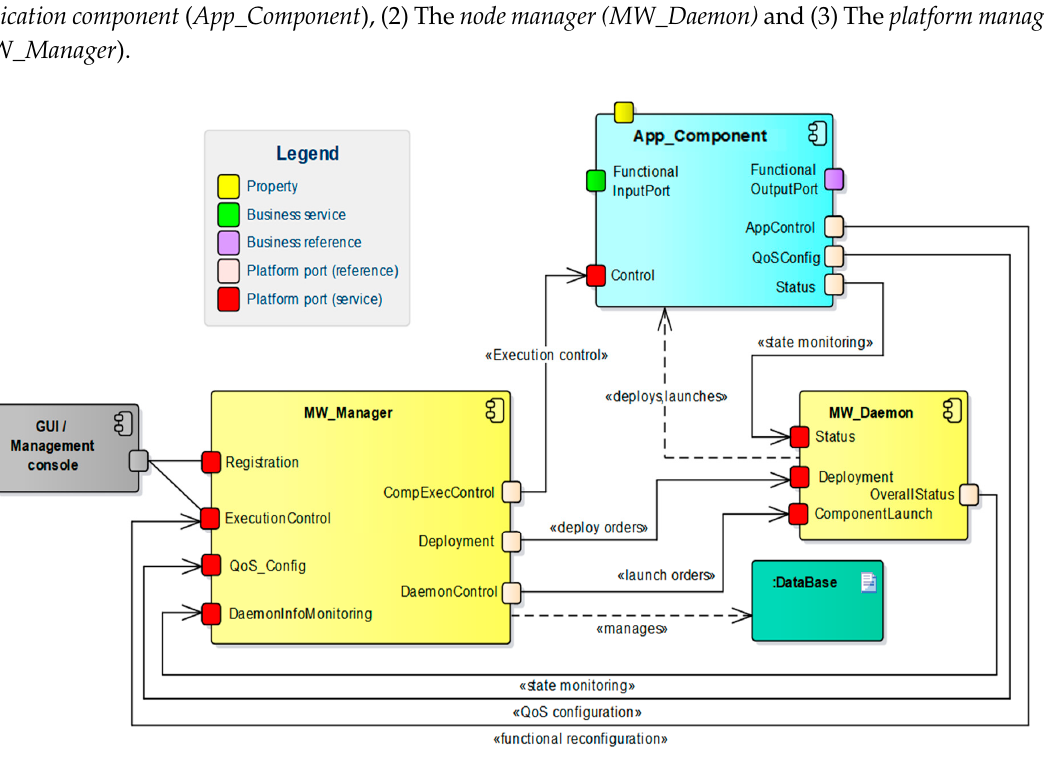
Figure 3 . Interconnections among DAMP components. Figure 3. Interconnections among DAMP